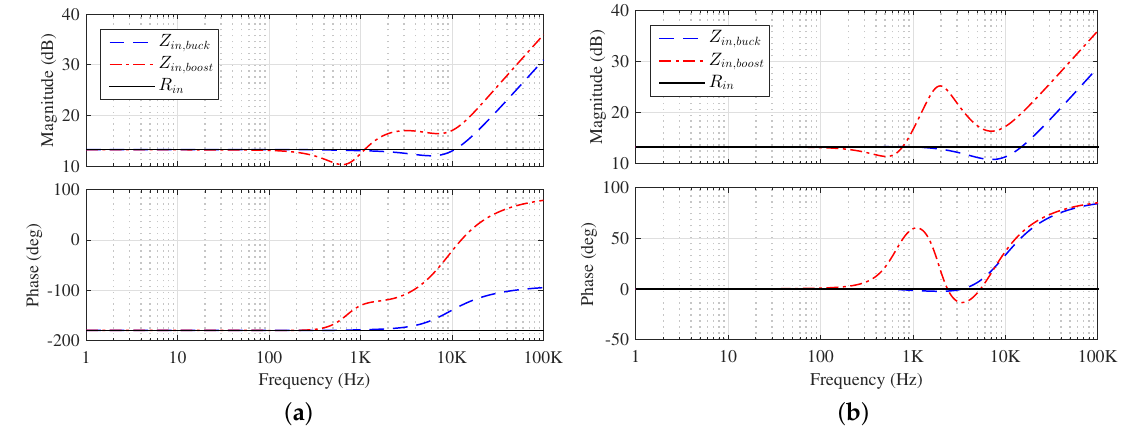
Figure 6. Comparison between the closed-loop input impedance Z in and incremental resistance R in of a device-regulating converter when ( a ) P dev > 0 and ( b ) P dev < 0.